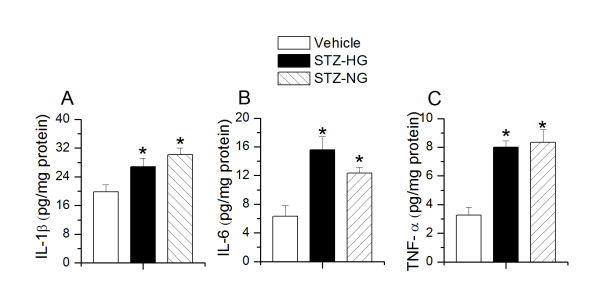
Effect of intraperitoneal administration of STZ on spinal pro-inflammatory cytokine levels. Interleukin-1β(IL-1β)(A), Interleukin-6(IL-6)(B), Tumor necrosis factor-α (TNF-α)(C) in lumbar spinal cord tissue homogenates. Asterisk (*) represent p < 0.05 as compared to vehicle-treated rats.